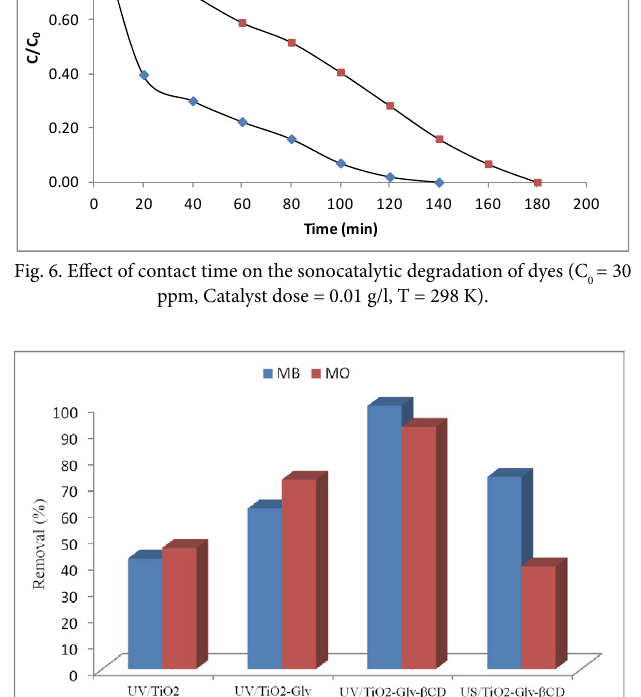
Fig. 7 Fig. 7. Decolorization efficiency of dyes in UV/TiO 2 , UV/TiO 2 -Gly, UV/TiO 2 - Gly- β CD and US/TiO -Gly- β CD systems (Contact time = 80 min., Optimum pH 2 values, catalyst dose = 0.01 g/l, T = 298